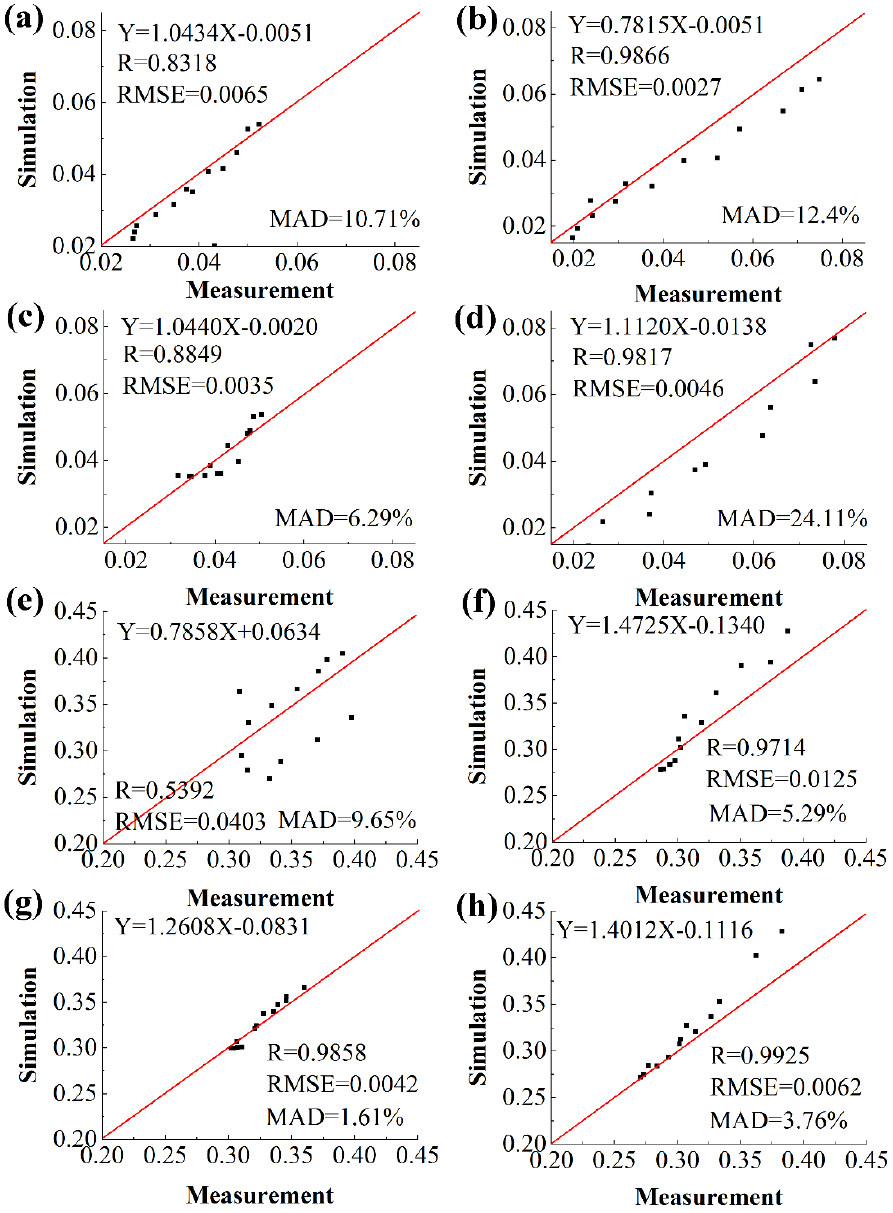
Figure 12. Statistics of the distribution of the sum of the reflectance simulated by the row model and field data in the multiangle observation for the principal plane (PP) mode ( a , e ), orthogonal plane (OP) mode ( b , f ), along-row plane (AR) mode ( c , g ) and orthogonal row plane (OR) mode ( d , h ). The red line is a 1:1 line. R is the correlation coefficient, RMSE is the root mean square error, and MAD is the mean absolute deviation, which represents the difference between Data A and Data B , expressed as a percentage. Its expression is m 1 (cid:12) ( A − B ) / B (cid:12) . Here, m is the number of comparison groups, A is the sum of the reflectance simulated by the row model, and B is field data.